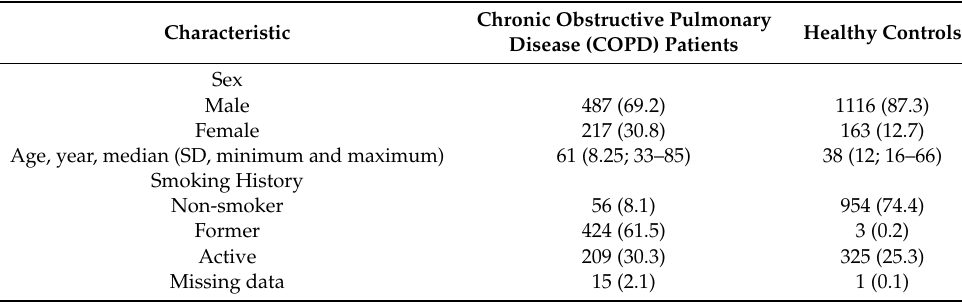
Table 1. Demographic characteristics of the tested population.